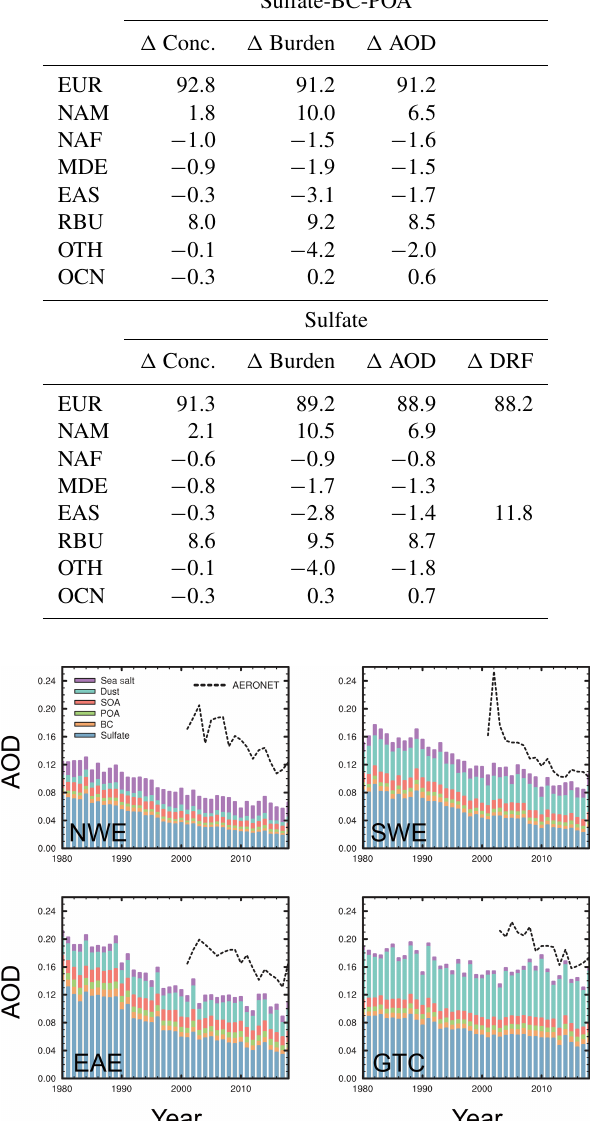
Figure 8. Time series (1980–2018) of simulated annual mean AOD for sulfate, BC, POA, SOA, dust, and sea salt averaged over the four subregions of Europe. Dashed lines represent AOD from AERONET